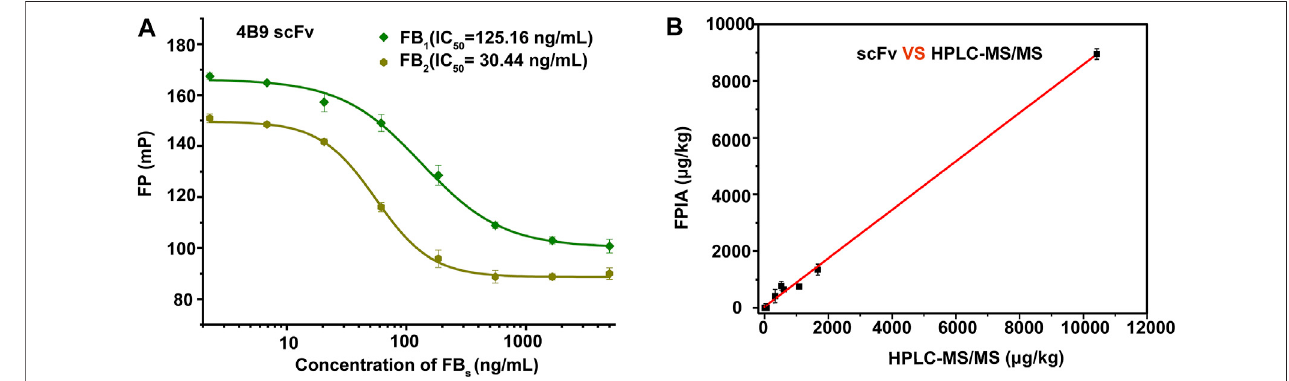
FIGURE 3 | Matrix effect and precise analysis of the FIPA. (A) : Calibration curves in a blank maize matrix of FPIA with 4B9 scFv. (B) : Correlation analysis between HPLC – MS/MS and the developed FPIA ( n = 3).